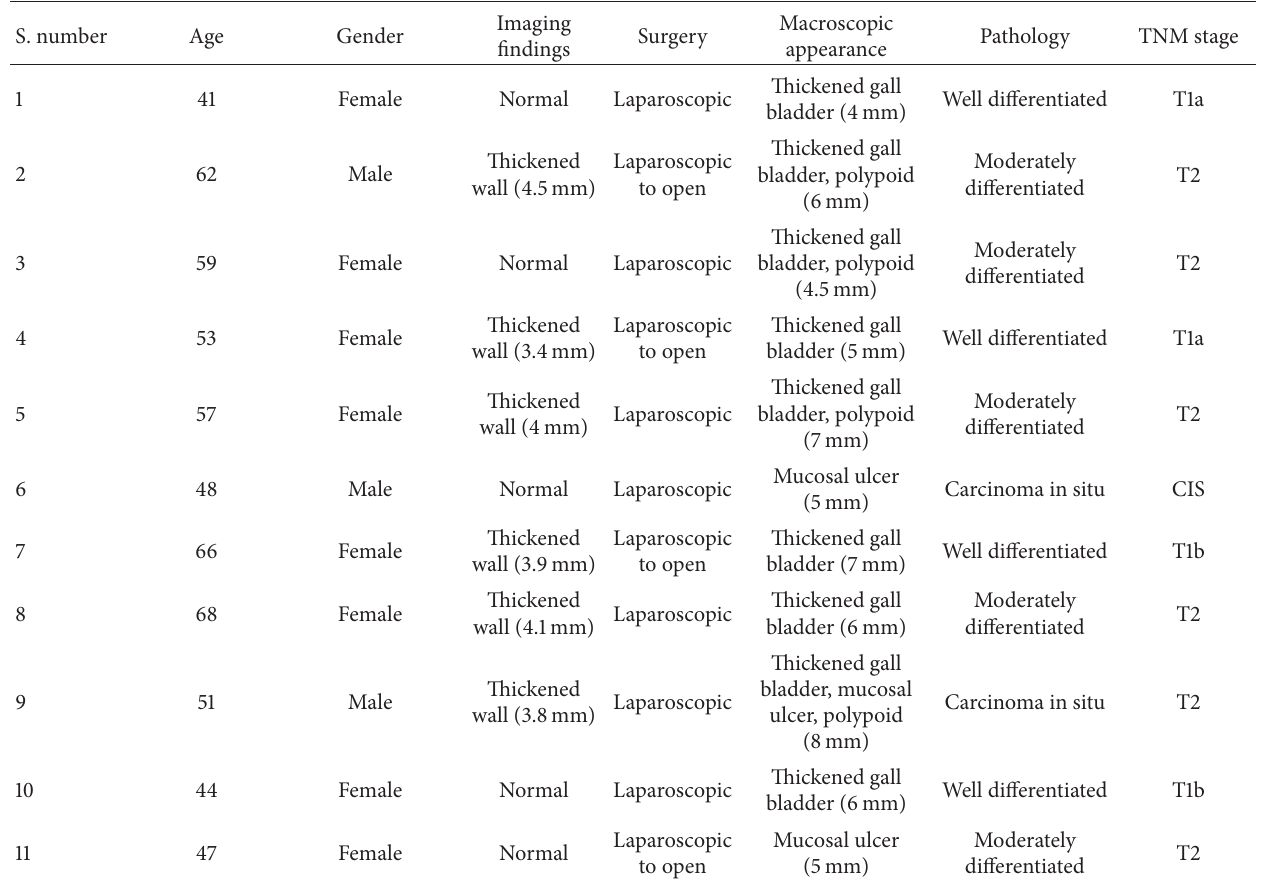
Table 3: Brief description of patients with incidentally identified gall bladder carcinoma. S.